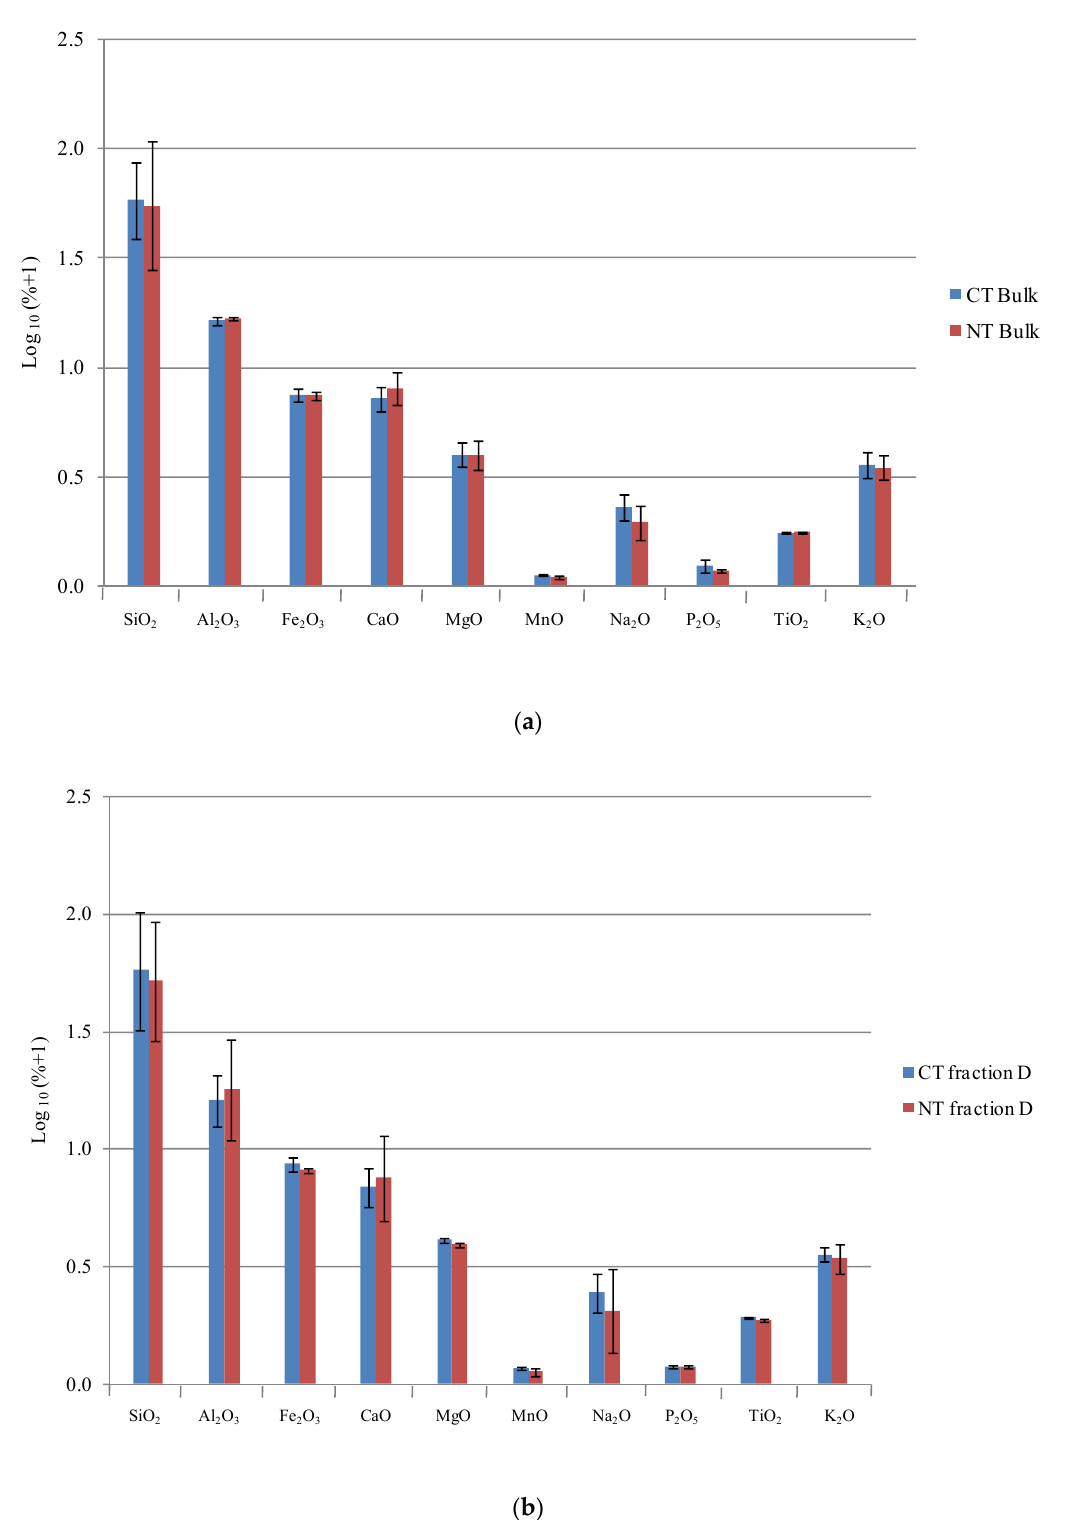
Figure 1. Major element concentrations, expressed as log 10 (percentage + 1) of no tillage (NT) and conventional tillage (CT) treatments at 0–30 cm depth. ( a ) Bulk soils; ( b ) D fractions. Error bars indicate standard deviations of three laboratory replicates.